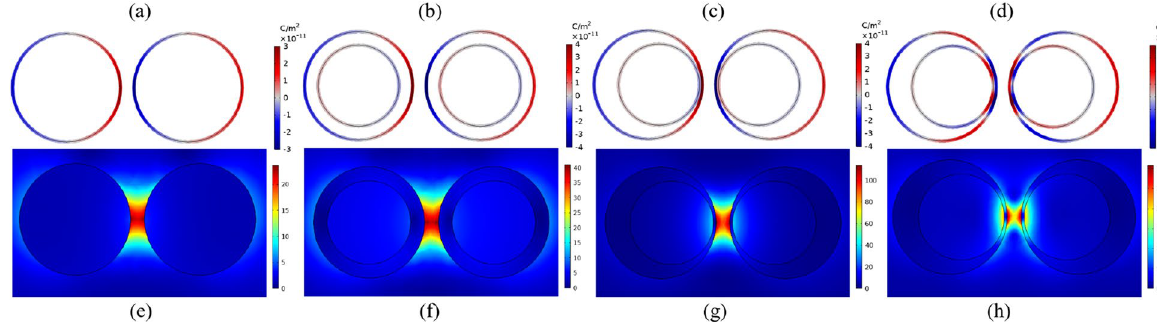
Figure 3. Top panel: Surface Charge distribution of bonding plasmon mode of ( a ) SSD ( b ) CSD, ( c ) NED and ( d ) higher-order plasmon mode of NED. Red color represents positive charge while blue is negative. Bottom panel: E-field maps of the dimer calculated at the resonance wavelength. ( e ) SSD at (cid:31) BDP = 542 nm , ( f ) CSD at = 584 nm = 625 nm , ( g ) NED at (cid:31) = 719 nm and ( h ) NED at (cid:31) (cid:31) HO BPD BDP